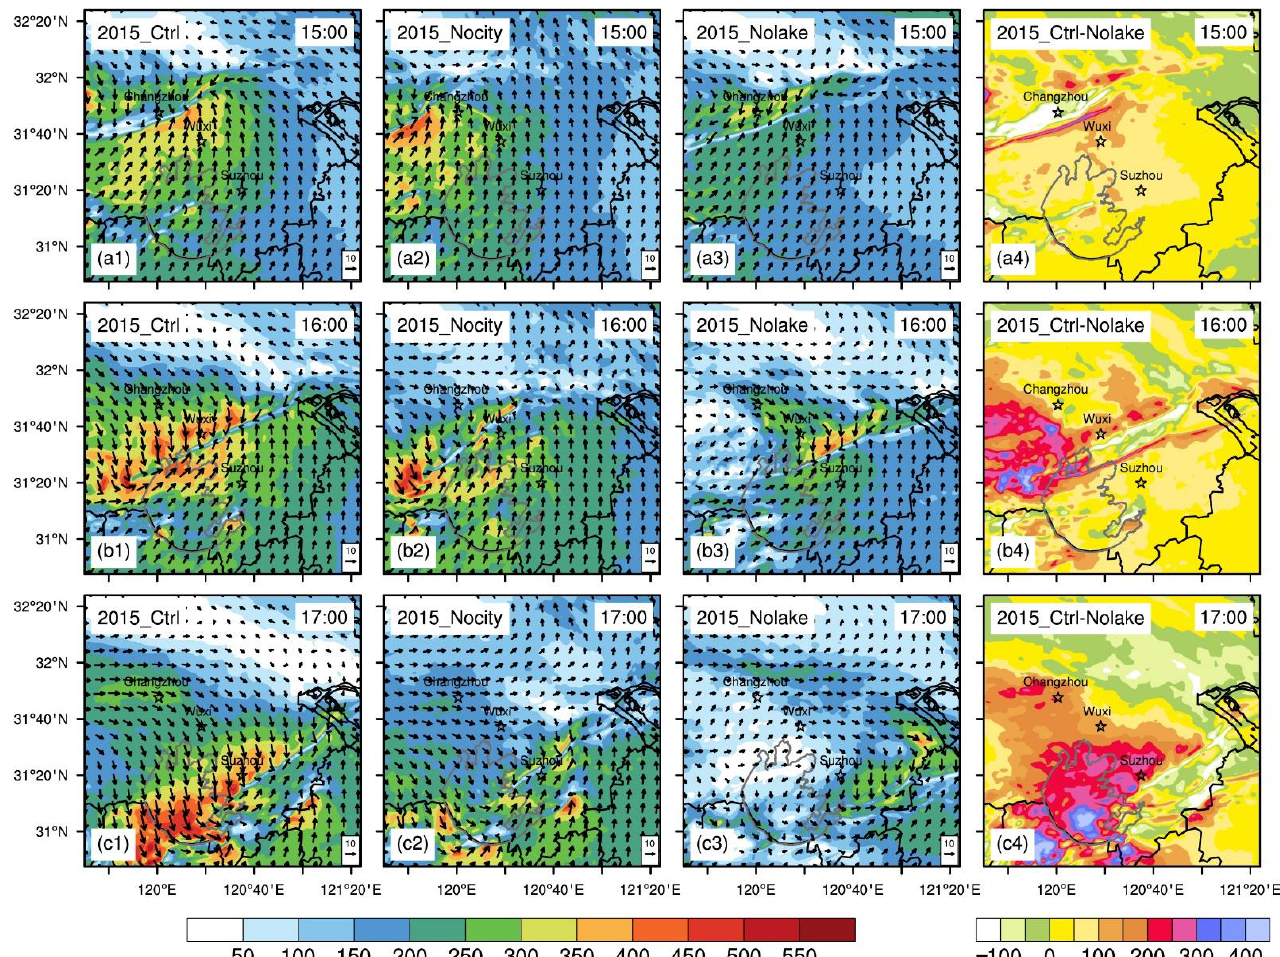
Figure 12. The spatial distributions of the water vapor fluxes (shaded, unit: kg m −1 s −1 ) integrated from 1000 hPa to 850 hPa and the mean horizontal wind directions (arrows, unit: m s −1 ) for the ( a1 , b1 , c1 ) control, ( a2 , b2 , c2 ) Nocity, ( a3 , b3 , c3 ) Nolake runs, and ( a4 , b4 , c4 ) the difference of water vapor fluxes between the control and Nolake runs for EP627.